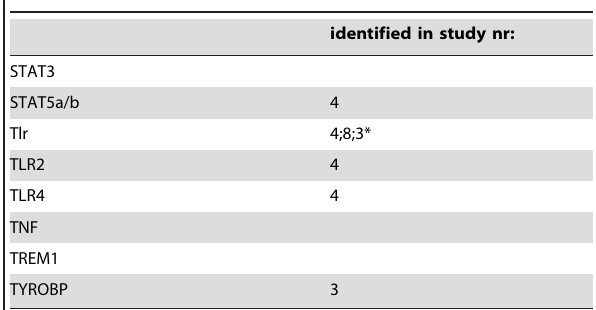
Table 5. TREM1 canonical pathway. Table 5.